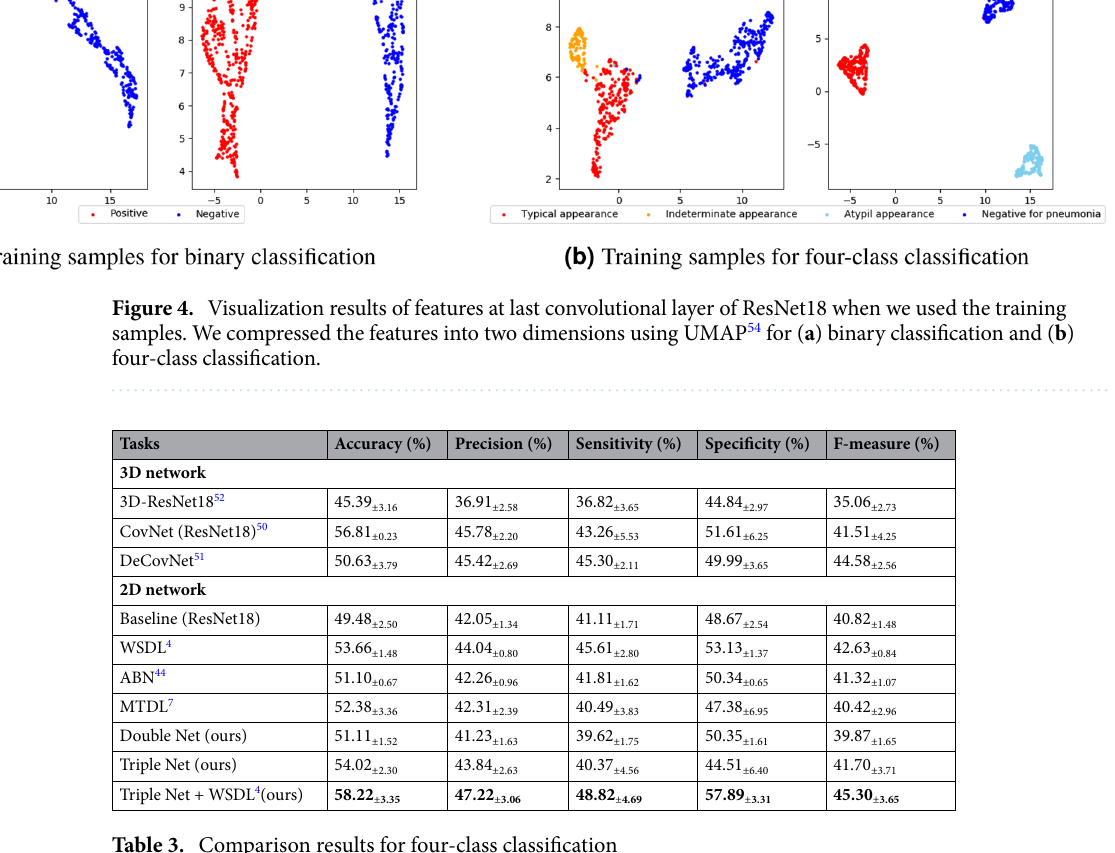
Table 3. Comparison results for four-class classification